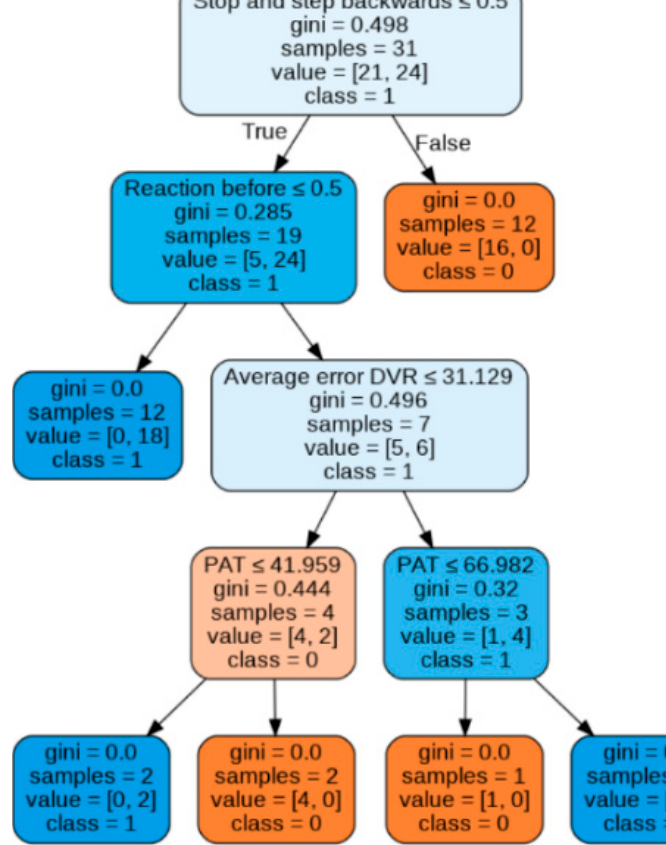
Figure 15. Individual tree of the Random Forest ensemble.